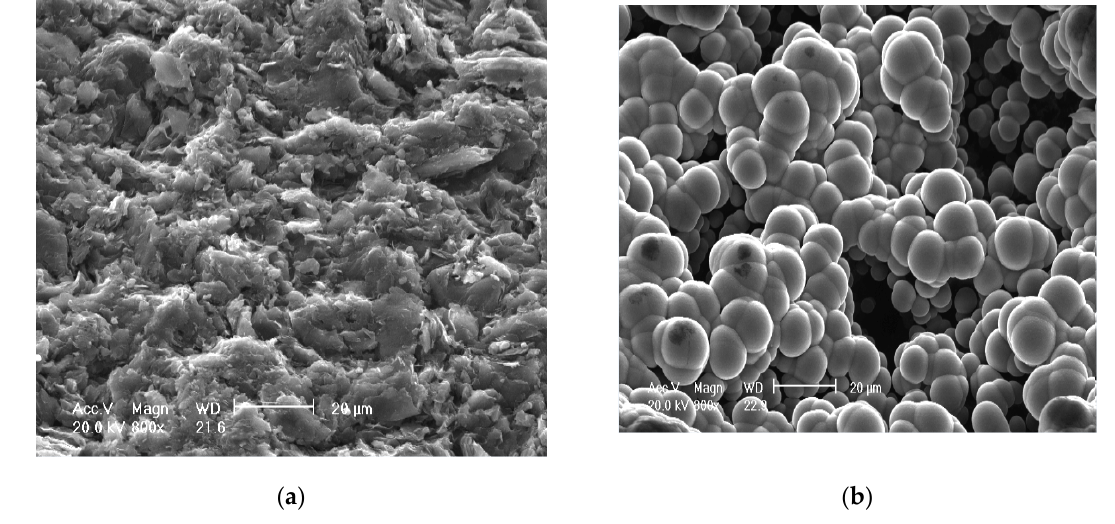
Figure 4. SEM (scanning electron microscope) of the probe surfaces before use: ( a ) uncoated graphite; ( b ) ultra-nano-crystalline diamond (UNCD)-coated surface.